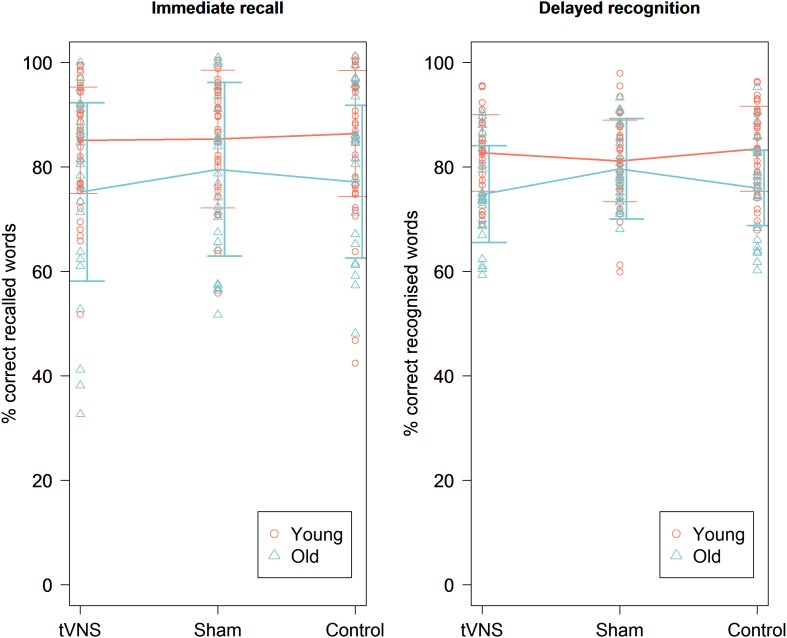
Immediate recall (left) and delayed recognition (right) accuracy scores in percentage for the three experimental conditions for the young and old age group. There was no significant effect of experimental condition on immediate recall and delayed recognition scores in both age groups. Line plots represent mean scores. Error bars represent standard error.